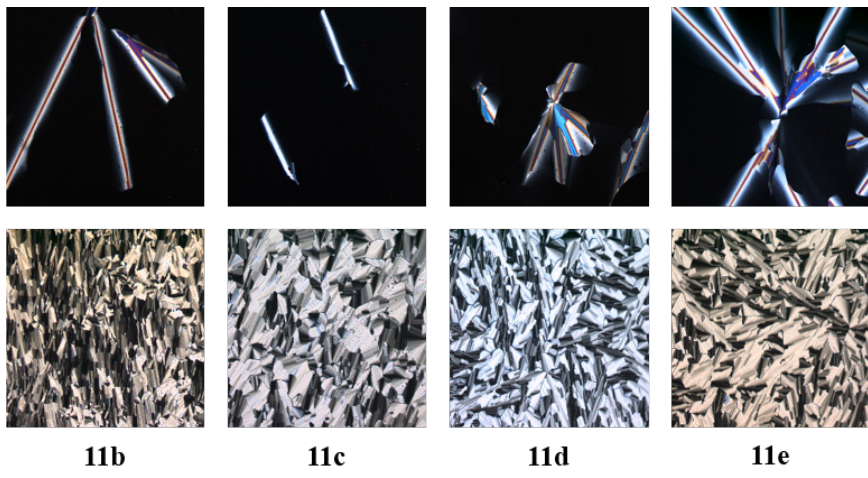
Figure 4. Textures of 11b – e as seen between crossed polarizers upon cooling from isotropic liquid (cooling rate 5 K·min − 1 , magnification ×100). ( top ): standard glass slides, ( bottom ): trimethylchlorosilane-treated glass